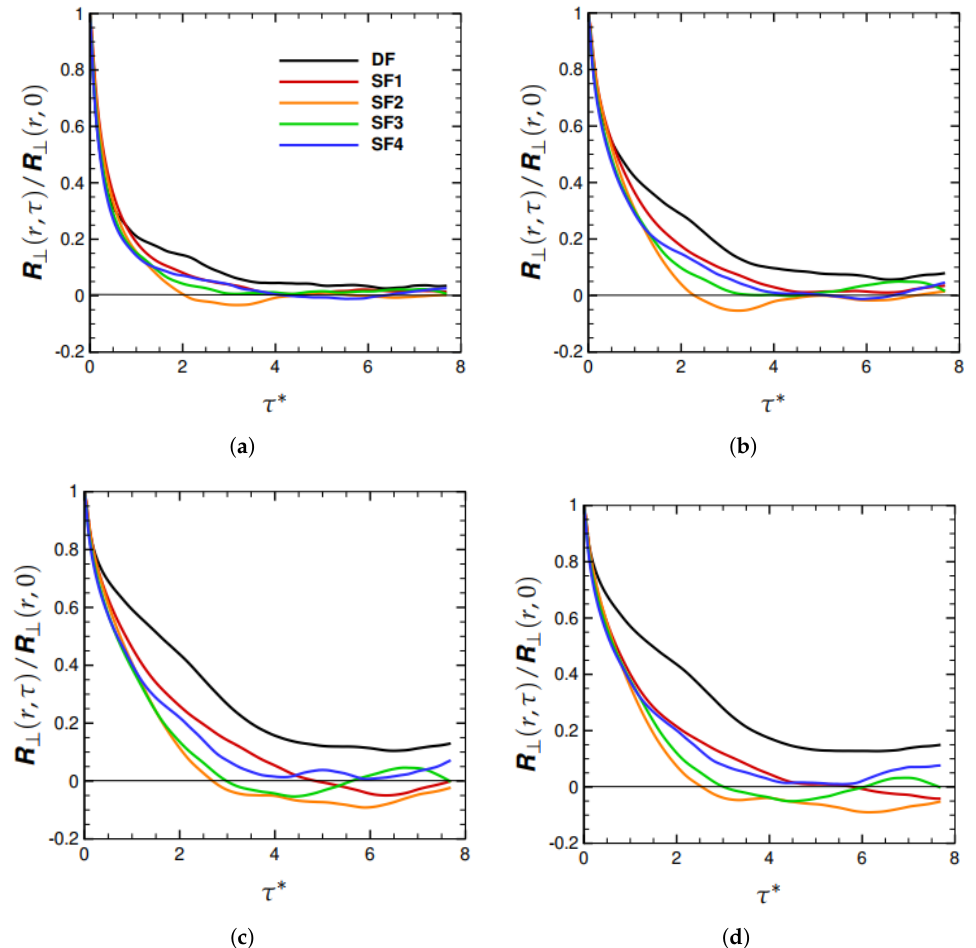
Figure 4. R ⊥ ( r , τ ) = (cid:104) ∆ u ( r , x ,0 ) ∆ u ( r , x , τ ) (cid:105) ⊥ as a function of dimensionless time